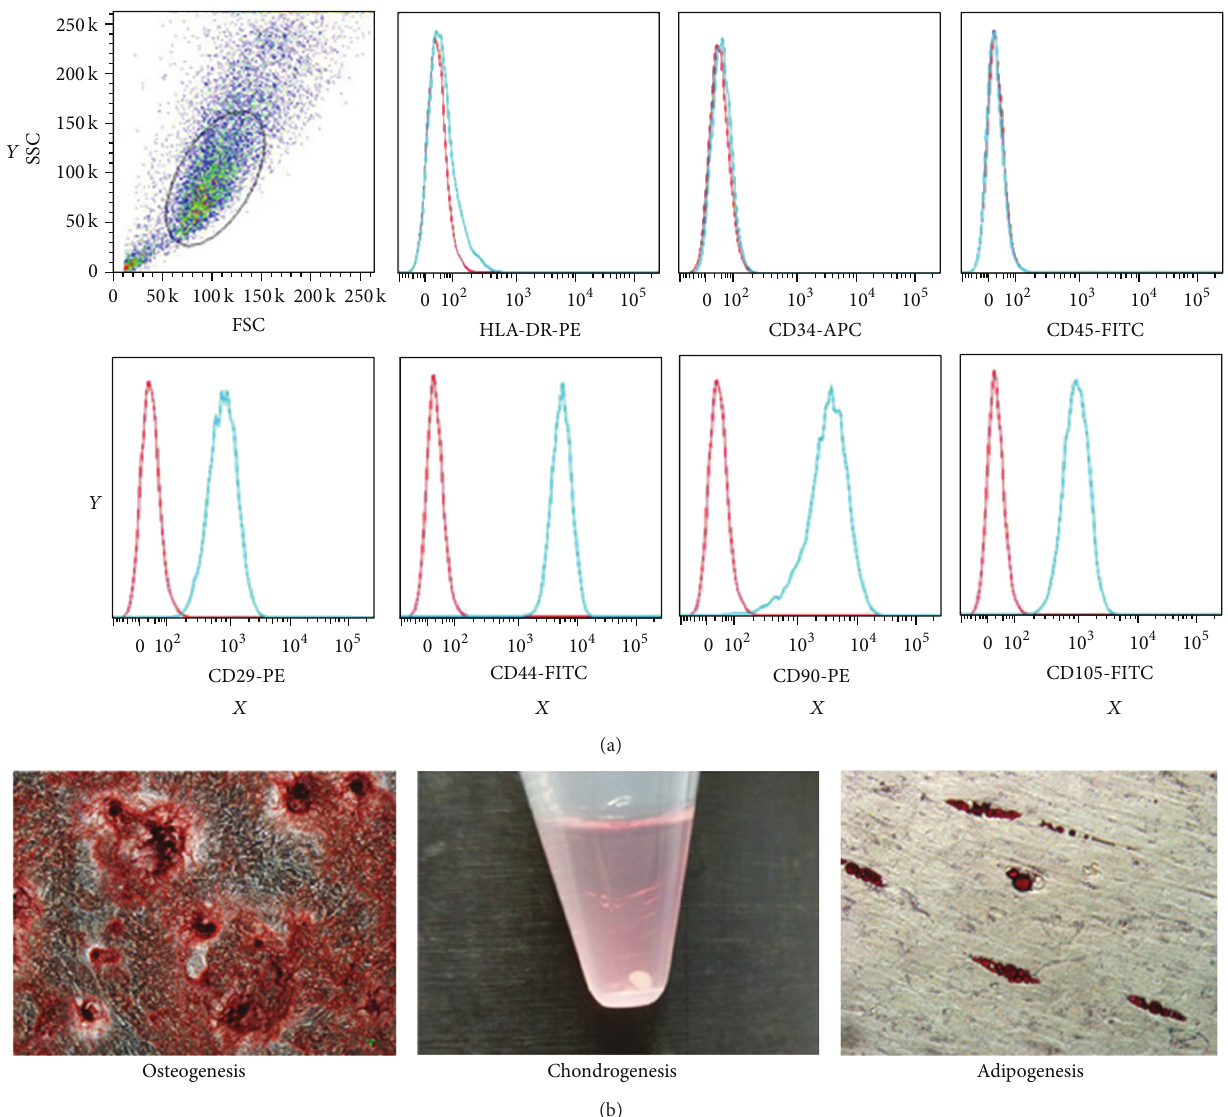
Figure1:IdentificationofMSCs.(a)Phenotypiccharacterizationbasedonanumberofsurfacemarkers.MSCswerepositiveforCD29,CD44, CD90, and CD105, but negative for HLA-DR, CD34, and CD45. Red line: background fluorescence of isotype controls. Blue line: fluorescence intensity from selected markers. 𝑋 -axis: fluorescence intensity. 𝑌 -axis: cell count. (b) Trilineage